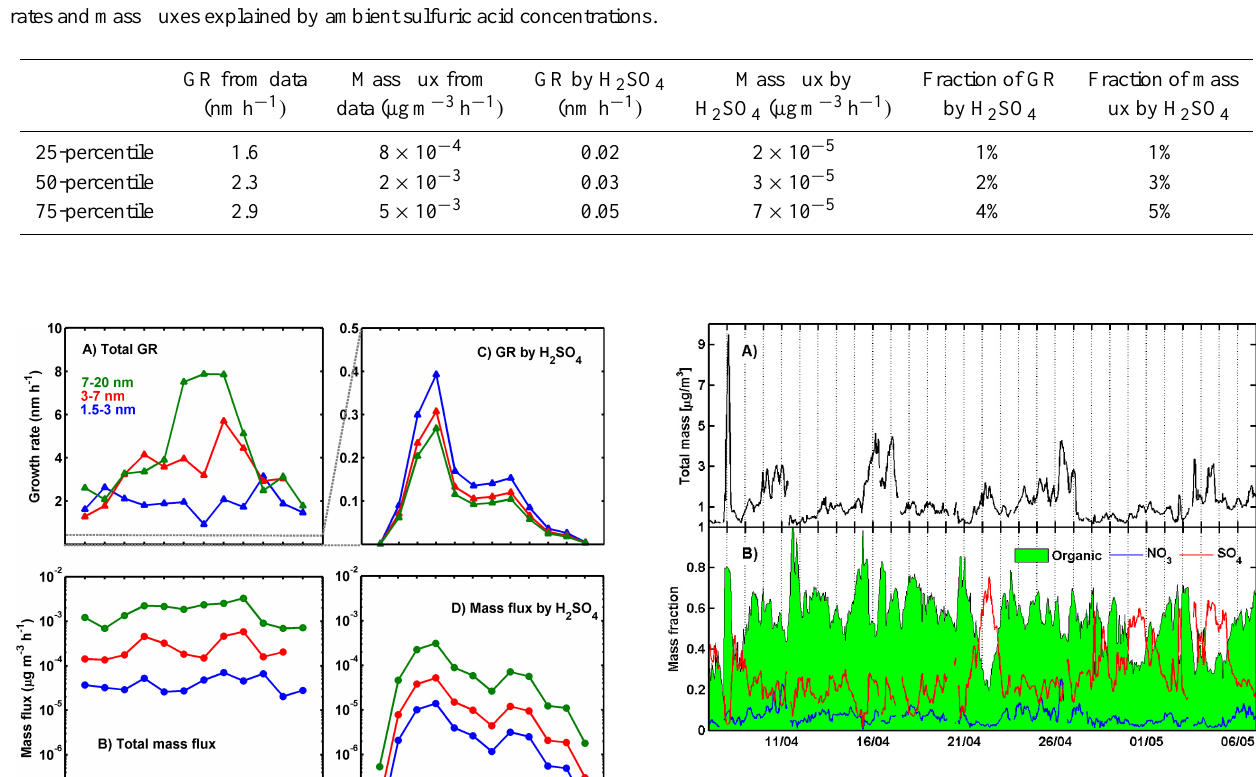
Fig. 4. The total aerosol mass concentration (A) and the fraction of organic, nitrate and sulphate aerosol (B) as recorded with the AMS during spring 2007 in Hyyti¨al¨a,